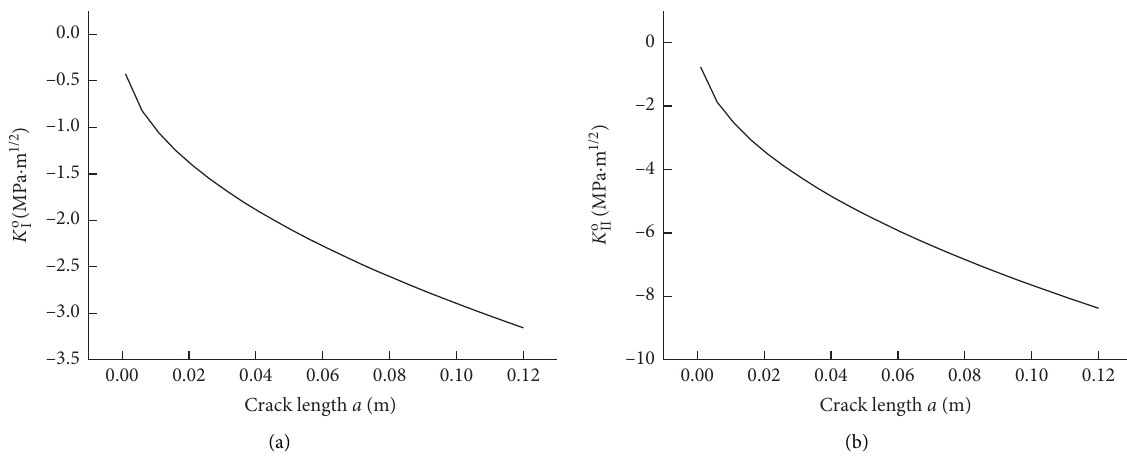
Figure 12: Relationship between open crack length and stress intensity factor ( θ � 70 ° ). (a) Mode I. (b) Mode II.